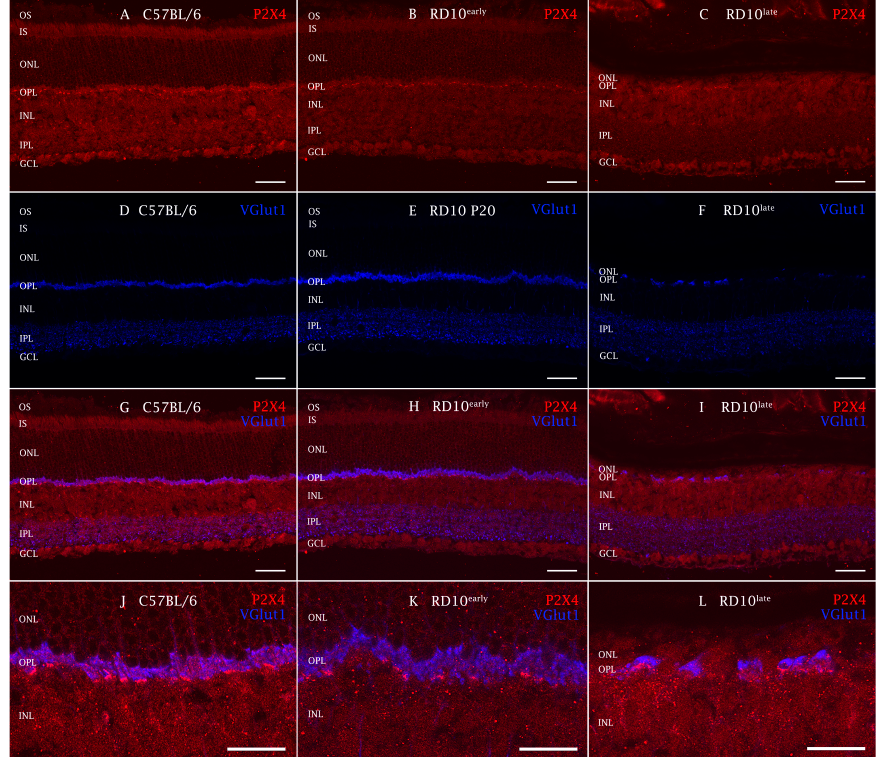
Figure 5. P2X4R expression in mouse retinas analyzed by immunohistochemistry. Cross-sectional cryosections of retinas from a representative C57BL/6J mouse ( A , D , G , J ) and rd10early ( B , E , H , K ) and rd10late ( C , F , I , L ) mice. Sections were stained with antibodies against P2X4R ( A – C , G – L ) and the vesicular glutamate transporter VGlut1 ( D – L ). Immunopositive areas of P2X4R appear in the terminal zone of the photoreceptors close to the VGlut1 immunoreactive zones (less noticeable in rd10late when most of the cones have disappeared) and GCL. RPE: retinal pigment epithelial cells; OS: outer segments; IS: inner segments; ONL: outer nuclear layer; OPL: outer plexiform layer; INL: inner nuclear layer; IPL: inner plexiform layer; GCL: ganglion cell layer. Scale bar: 50 µ m. C57BL/6J: postnatal day (P)30; rd10early: P20 and rd10late: